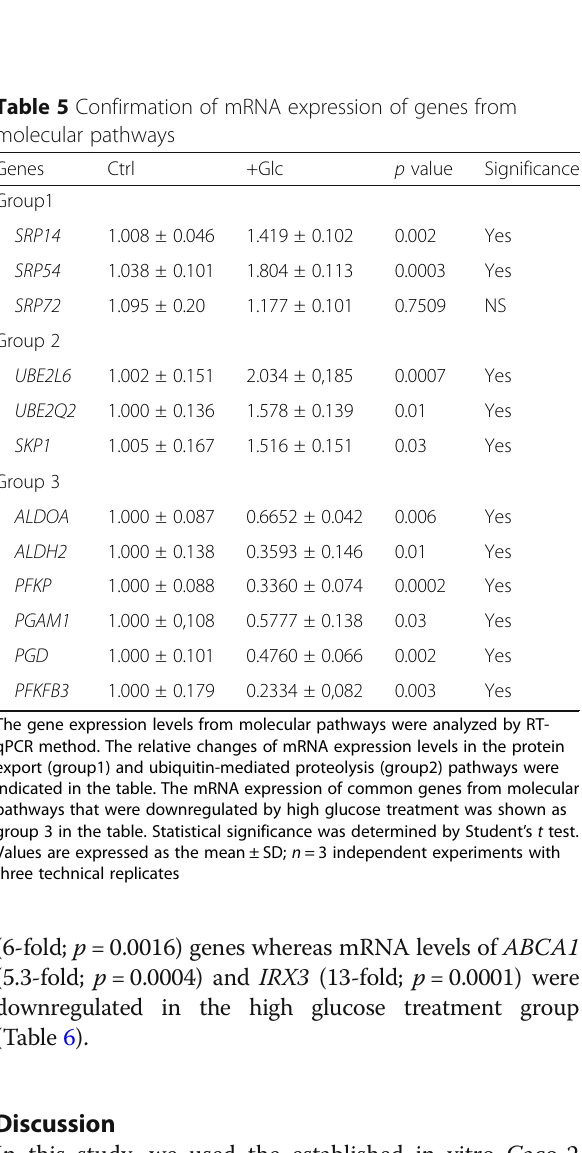
(6-fold; p = 0.0016) genes whereas mRNA levels of ABCA1 (5.3-fold; p = 0.0004) and IRX3 (13-fold; p = 0.0001) were downregulated in the high glucose treatment group (Table 6).